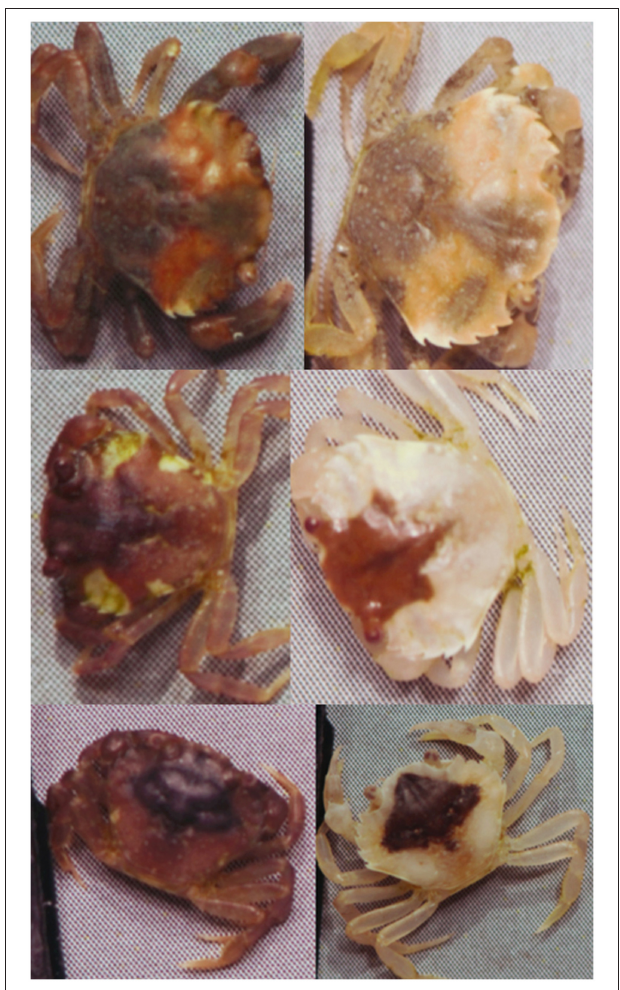
FIGURE 2 | Shore crabs ( Carcinus maenas ) kept on a heterogeneous light yellow sandy background can seemingly undergo considerable change in color and pattern as they molt (left = before molting, right =